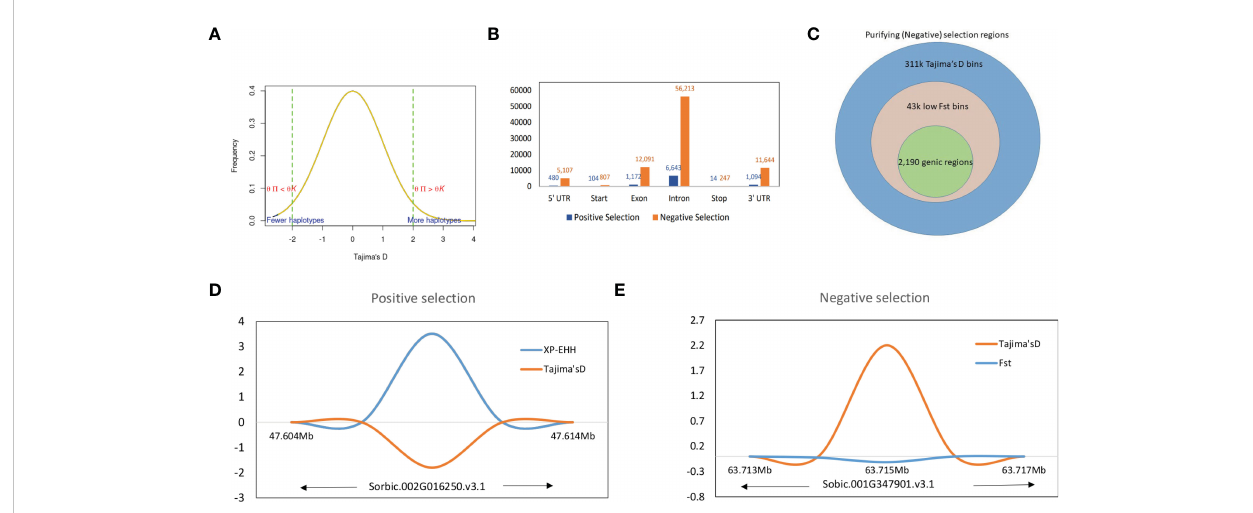
FIGURE 4 (A) Tajima ’ s D values distribution with signifying positive and negative thresholds. (B) Structural annotations of genomic regions in positive and negative thresholds. (C) The proportion of higher Tajima ’ s D values and lower Fst valued bins as negative selection regions and corresponding genic